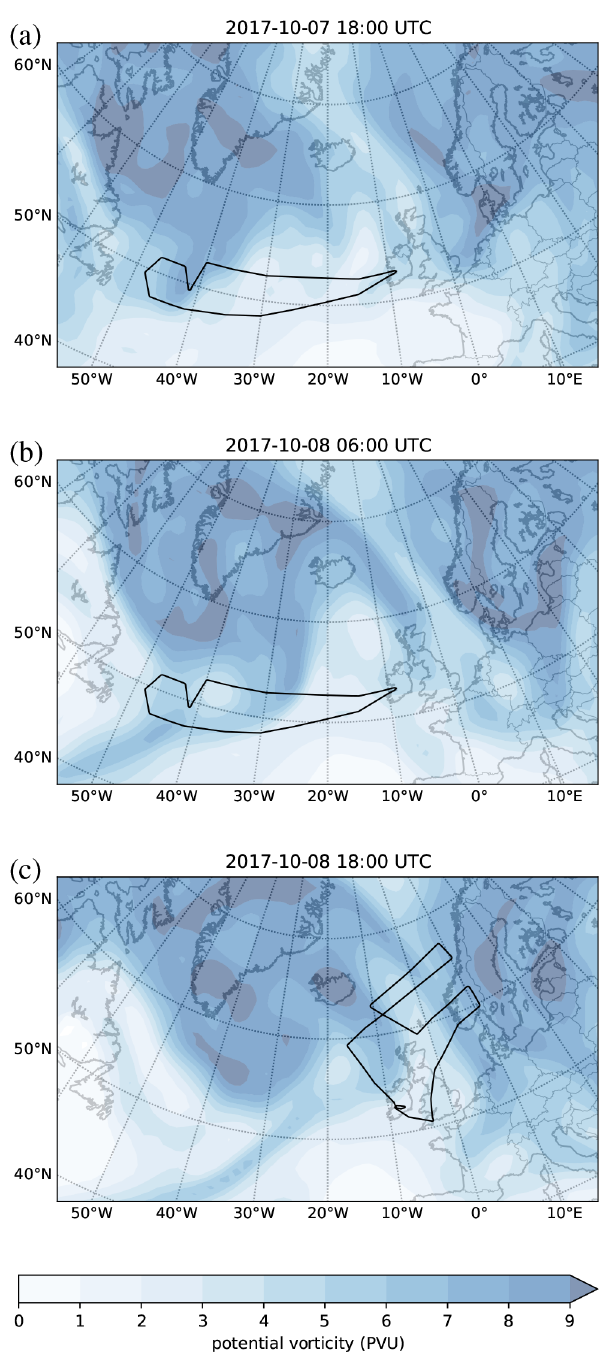
Figure D1. Potential vorticity at 340K potential temperature level, 7–8 October. Black lines show flight paths.